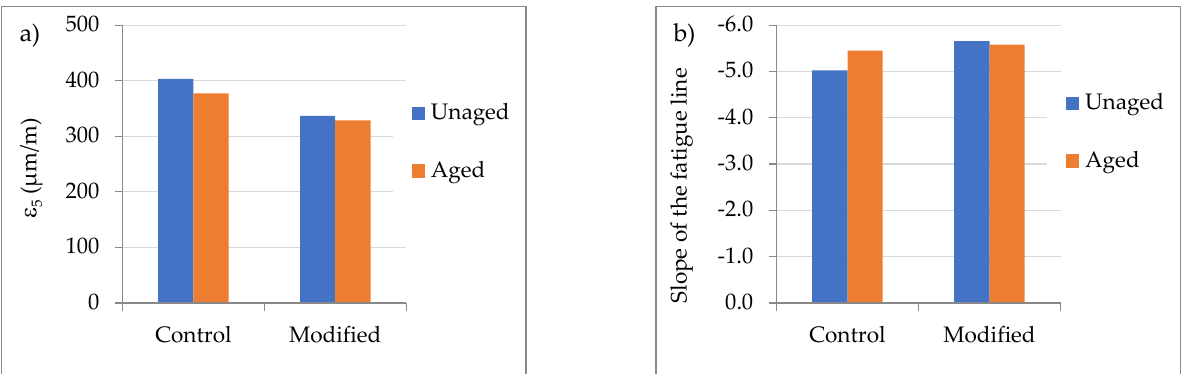
Figure 5. Fatigue lines of the control ( a ) and modified ( b ) SMA 8 in unaged and aged conditions.